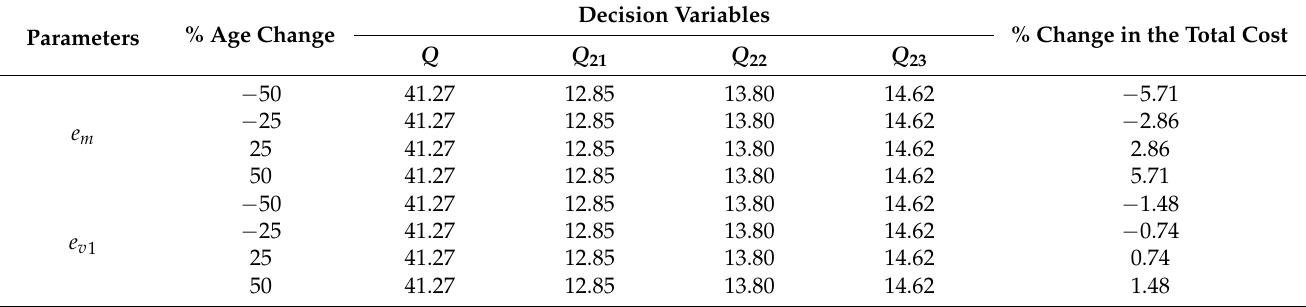
Table A5. Sensitivity analysis for carbon emission per unit item of manufacturer and